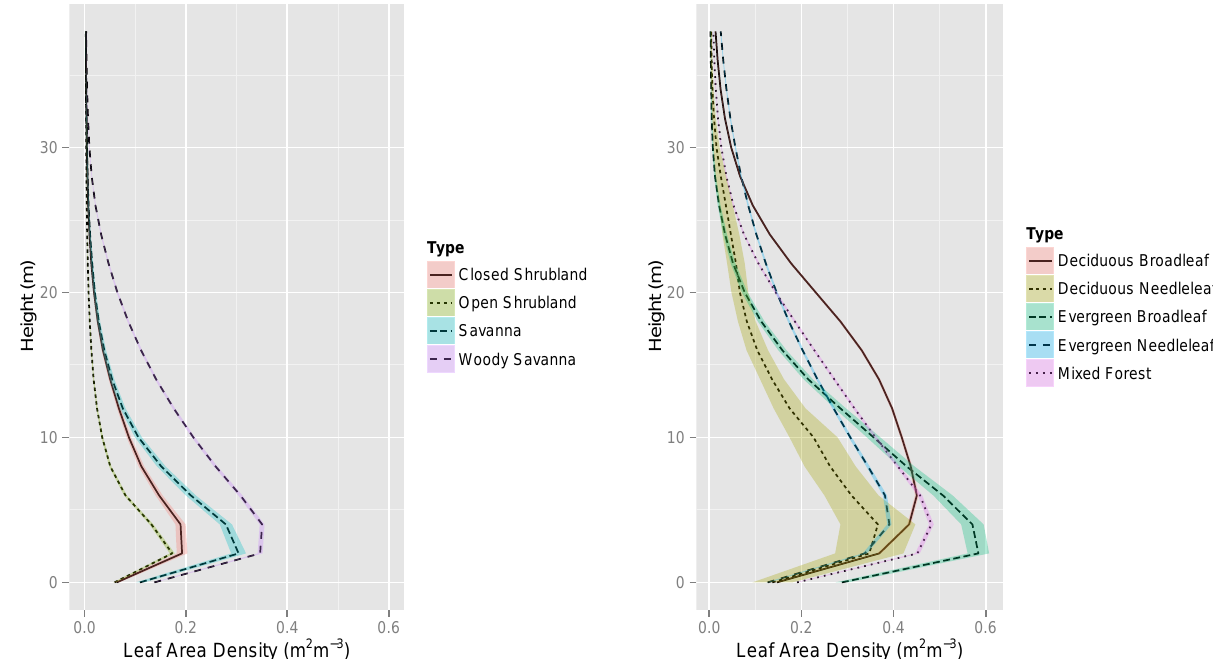
Figure 8. Averaged GLAS VFP for different land cover types across the US: non-forest vegetation types (left) and forest types (right). Mean values are central lines within the color-filled 95% CI